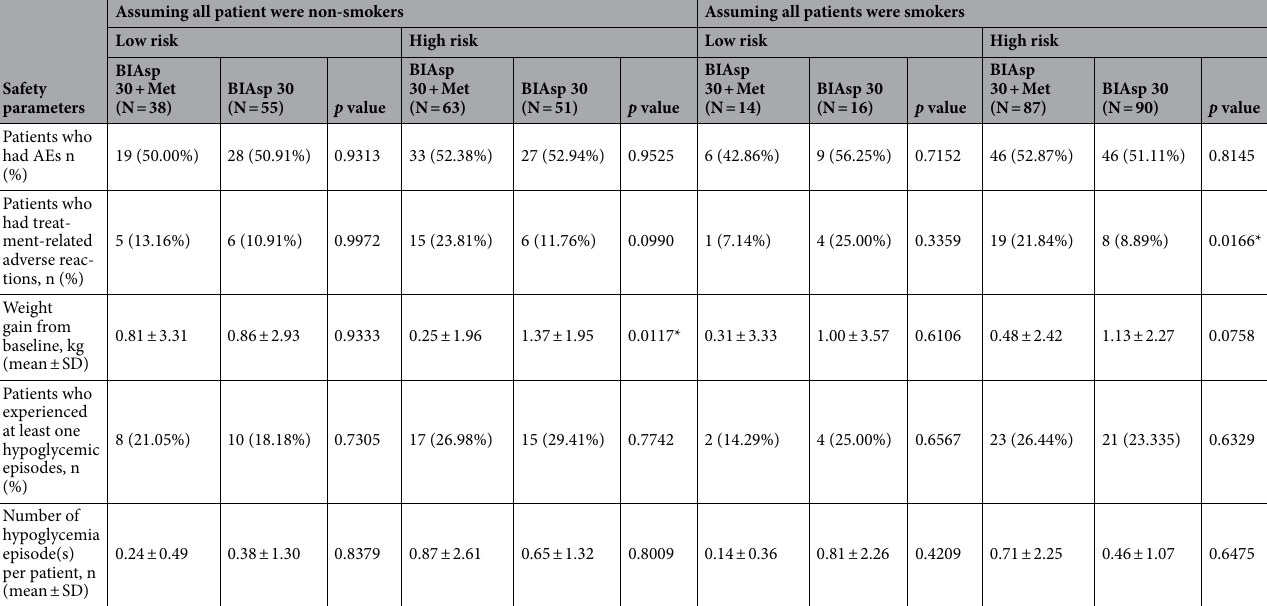
Table 2. Safety profiles of patients with low (< 20%) and high (≥ 20%) 10-year risk of cardiovascular disease receiving biphasic insulin aspart 30 (BIAsp 30) and metformin combination therapy or BIAsp 30 monotherapy (SS). SS safety set, BIAsp 30 biphasic insulin aspart 30, Met metformin, AEs adverse events, HbA1c standard deviation, GI gastrointestinal, AE adverse event. * p < 0.05.